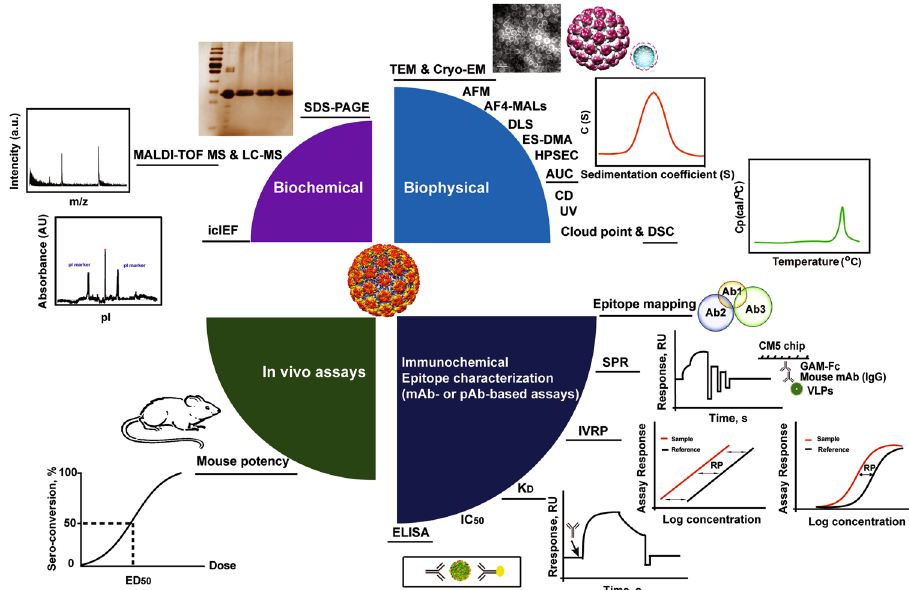
Fig. 2 Analytical toolbox for the characterization of VLPs. A series of modern techniques make up a “ toolbox ” that has been extensively used for structural and functional characterization of VLPs. Biochemical: SDS-PAGE sodium dodecyl sulphate polyacrylamide gel electrophoresis, MALDI-TOF MS matrix-assisted laser desorption/ionization time of fl ight mass spectrometry, 33 LC-MS liquid chromatography – mass spectrometry, 33 icIEF imaged capillary isoelectric focusing has been widely used for protein characterization, 33 Biophysical: the morphology of VLPs can be observed by TEM, Cry-EM, and AFM. TEM transmission electron microscopy, Cry-EM cry electron microscopy, 85 AFM atomic force microscopy, 114 AF4-MALS, DLS, ES-DMA, and HPSEC generally are used for the measurement the size of particles. AF4-MALS asymmetric fl ow fi eld- fl ow fractionation coupled with multiple-angle light scattering, 117, 118 DLS dynamic light scattering, 119 ES-DMA electrospray differential mobility analysis, 118 HPSEC high performance size exclusion chromatography, 33 AUC analytical ultracentrifugation, CD Circular dichroism, 33 UV ultraviolet spectroscopy, 33 DSC differential scanning calorimetry, mAb or pAb-based assays are used to measure the concentration of functional epitopes in the vaccine samples. Epitope-mapping: comparable of epitope overlap of VLPs in different vaccine samples by mAbs; SPR surface plasmon resonance, IVRP in vitro relative potency, KD equilibrium dissociation constant, 114 IC 50 half maximal inhibitory concentration, ELISA enzyme-linked immunosorbent assay, The mini-VLP in the fi gure is the structure mode of HPV59, which was adapted from Structure, Li et al.